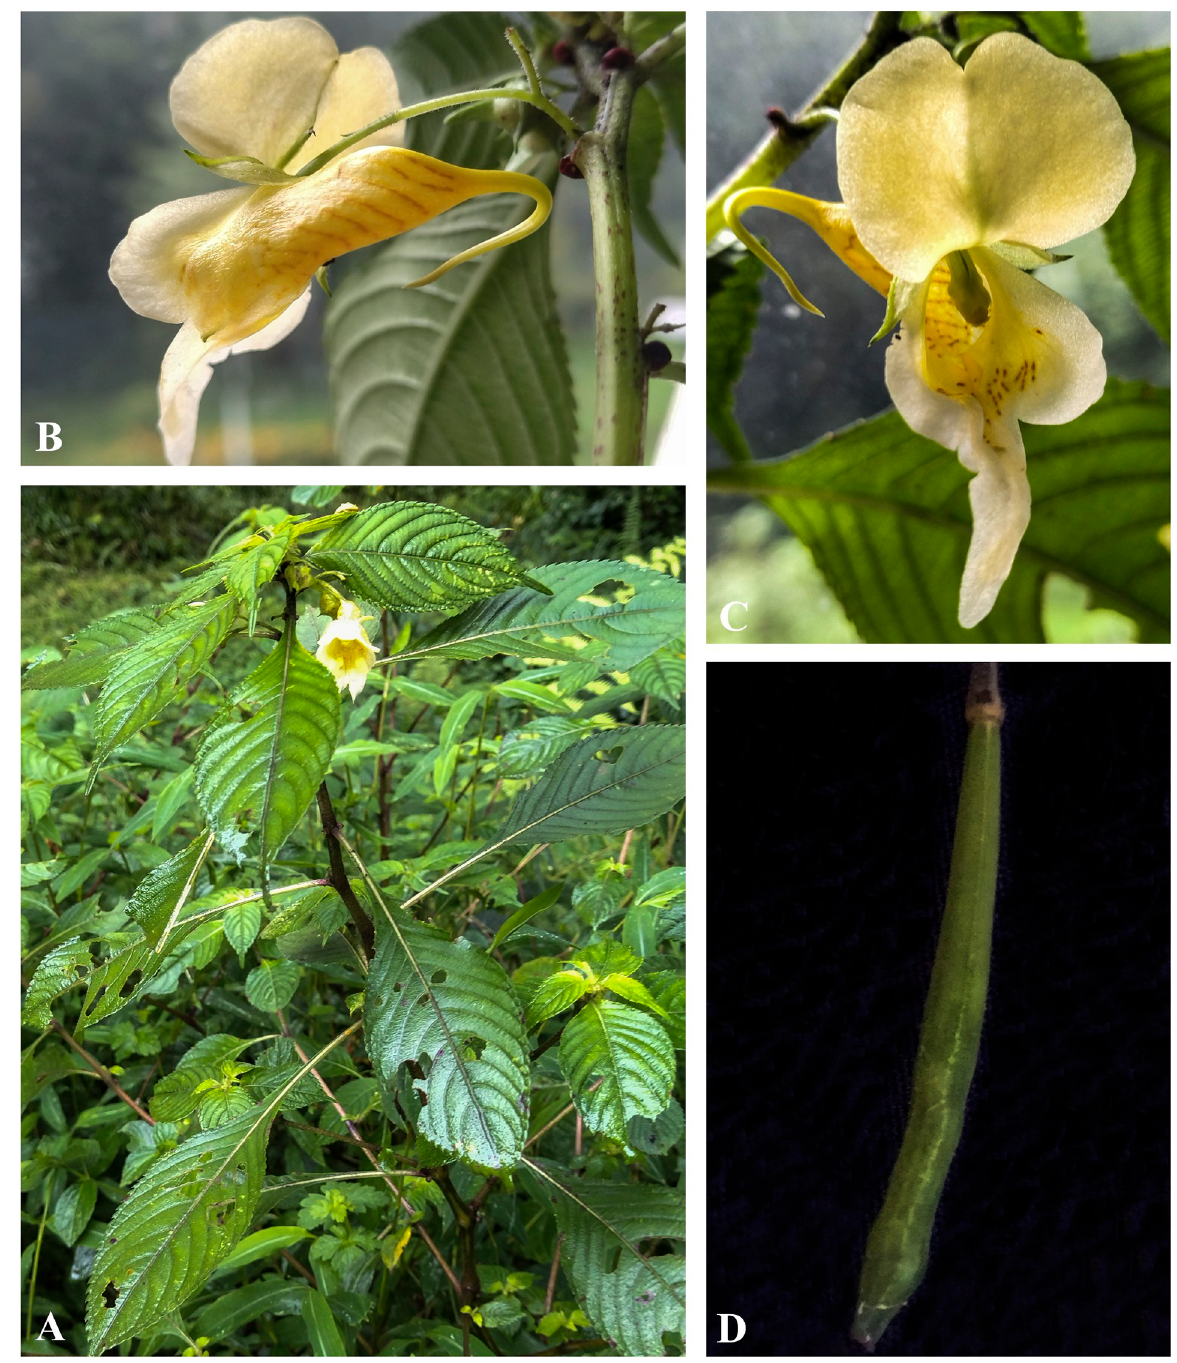
Fig 31. Impatiens tricoris A. Flowering plant; B. Side view of flower; C. Front view of flower; D. Capsule. Photographs by Bhakta Bahadur